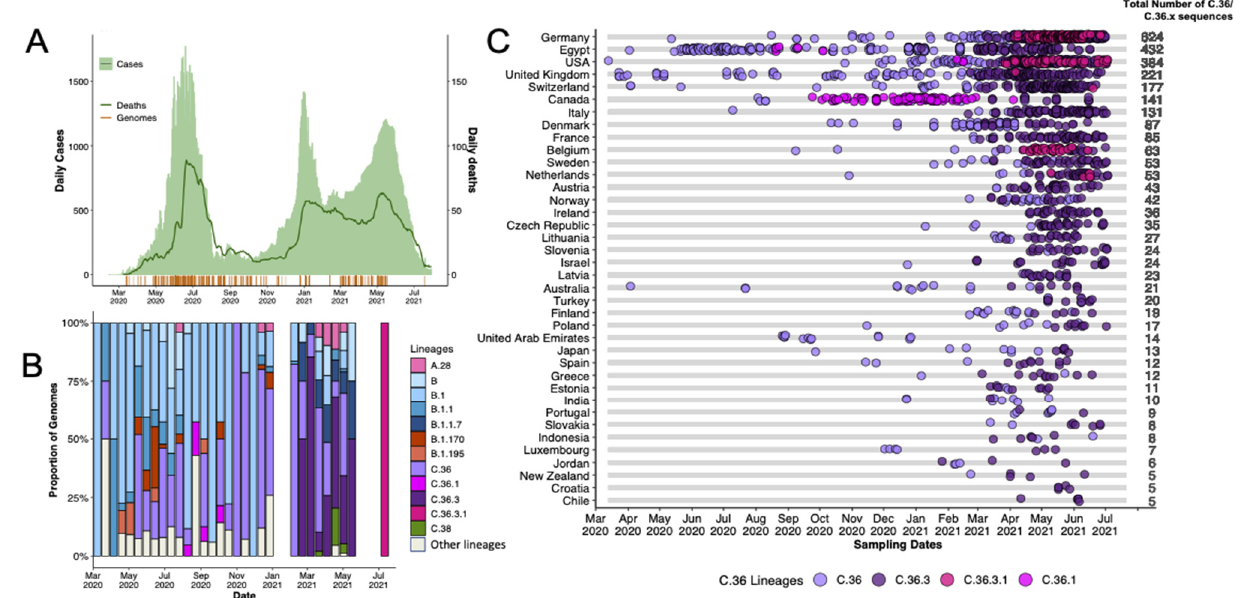
Figure 1. Epidemiological dynamics of the SARS-CoV-2 epidemic in Egypt. ( A ) Histogram showing the number of daily COVID-19 cases overlayed with a line plot of deaths: in the bottom, timing of the genomic sampling in Egypt. ( B ) Progressive distribution of the major SARS-CoV-2 lineages in Egypt. ( C ) Temporal sampling of sequences of the C.36 SARS-CoV-2 lineages globally in countries with at least 5 sequences (ordered by the total number of sequences). At the time of writing, there was only one sequence of lineage